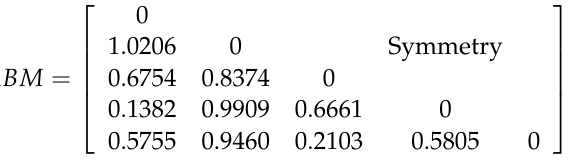
Table 5. Fusion process of the quality evaluation of rock mass in studied section.